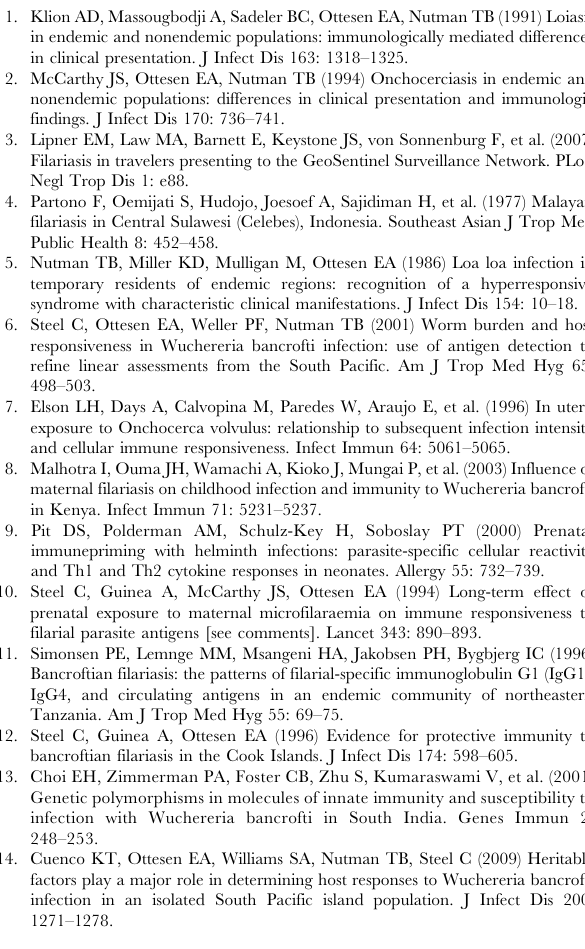
biological functions was determined by clustering analysis showing significant differential expression in the CD4 + T cells for upregulated genes (green bars, top right panel) and downregulated genes (blue bars, bottom right panel). Each bar in the plot represents the percent enrichment of a particular pathway (top axis) and an asterisk represents a significant corresponding p-value (FDR , 0.1) for the pathway (bottom axis). (TIF) Table S1 Quantitative RT-PCR and microarray values. Comparison of quantitative RT-PCR (Taqman TM ) and micro- array expression values in CD4 + and CD8 + unstimulated T cells. The data correspond to graphs illustrated in Figure 2 and represent the average values for the three individuals within each patient